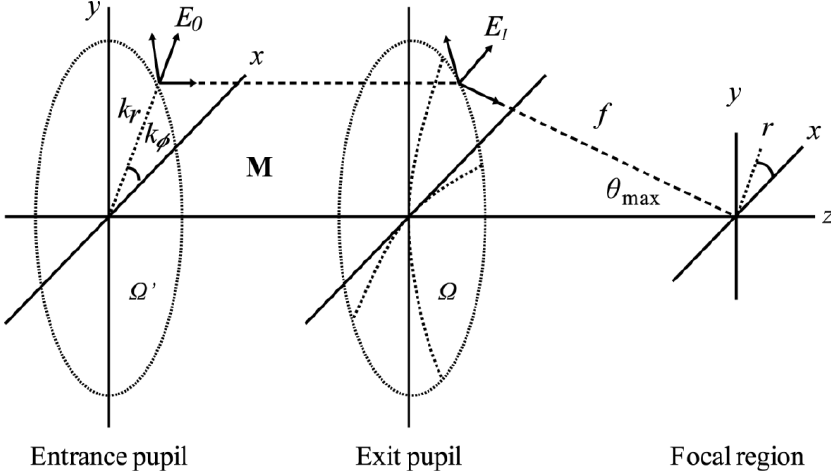
Figure 2. Notation scheme for the field vectors and coordinates of the optical